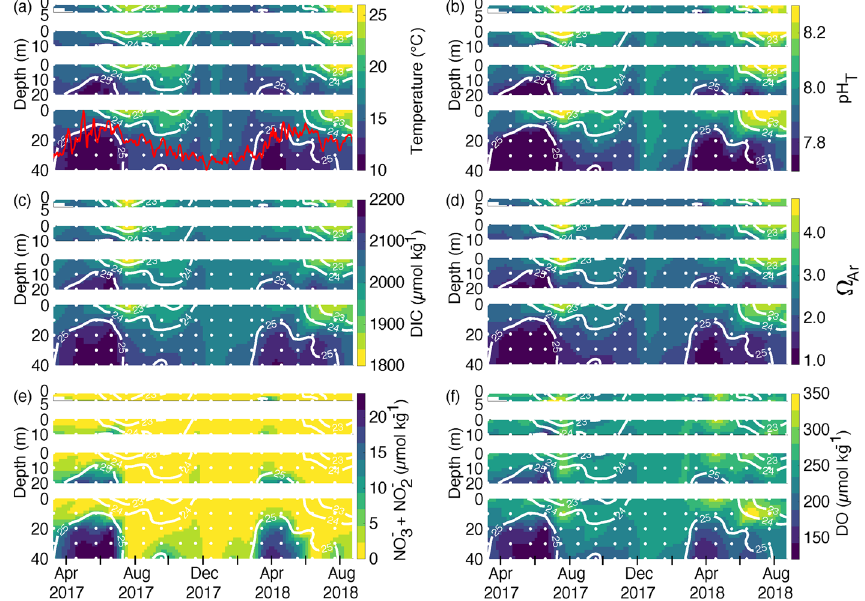
Figure 2. Spatiotemporal contours of seawater temperature ( a ), pH T ( b ), DIC ( c ), Ω Ar ( d ), [NO 3 − + NO 2 − ] ( e ), and DO ( f ) from March, 2017 to September, 2018. In each panel, the top subplot represents the most nearshore station (Stn 1) while subsequent subplots represent increasing distance from shore (Stn 1–4). White symbols represent discrete seawater samples, the white contour lines represent the 23.0, 24.0, and 25.0 kg m −3 σ θ isopycnals, and the red line in panel ( a ) shows the 7-day moving mean of relative upwelling intensity (upwelling intensity/maximum upwelling intensity) based on the Bakun traditional upwelling index at 33° N, 119° W (See Fig. S3 for